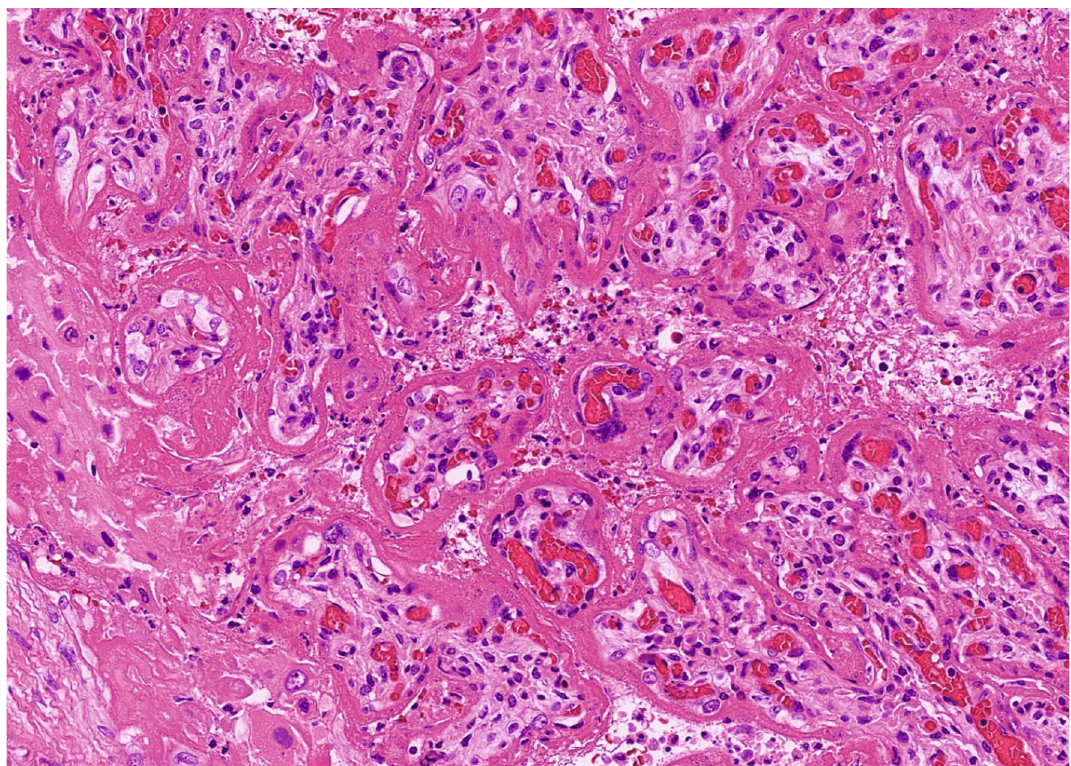
Figure 5: Microscopic picture descripting trophoblast necrosis, chronic histiocytic intervillositis, and perivillous fi brin deposition. Placenta from Case